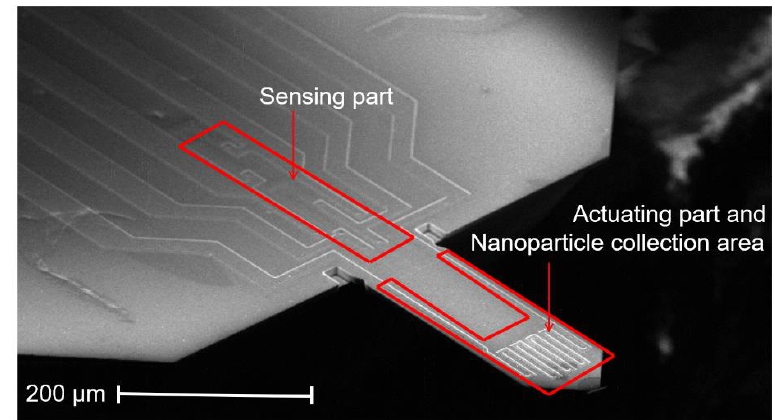
Figure 5. SEM image of the atomic force microscopy micro-cantilever sensor (AFM-MCS) showing the meander-shape thermal bimorph actuator at the cantilever free end and four resistors configured in a half Wheatstone bridge, i.e., two active (i.e., longitudinally strained) resistors and two passive (i.e., unstrained) resistors placed at the clamped end of the cantilever and embedded in the bulk chip region, respectively.